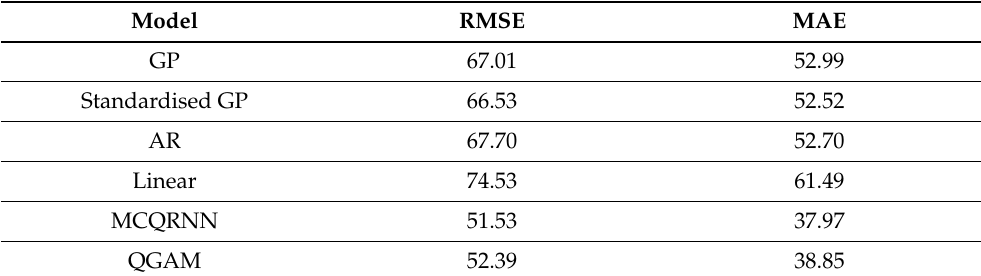
Table 8. Accuracy evaluations (Validation set (467)).